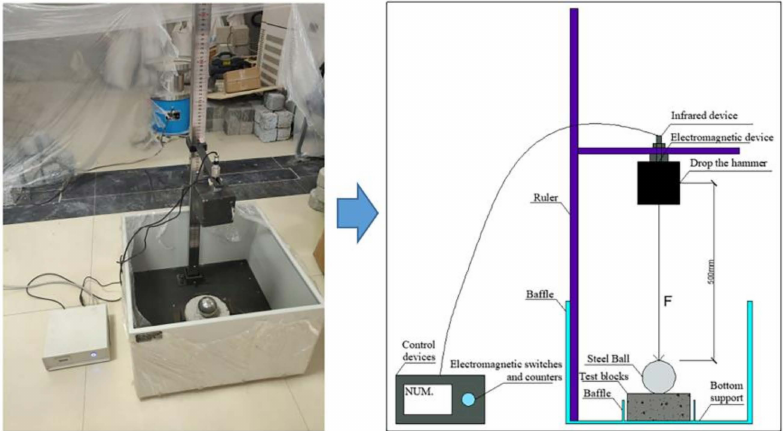
Figure 2. Drop-hammer impact